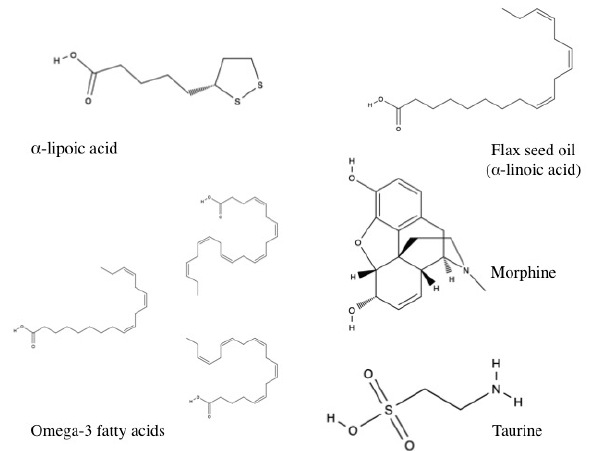
Figure 5. Structure of non-polyphenol antioxidants.